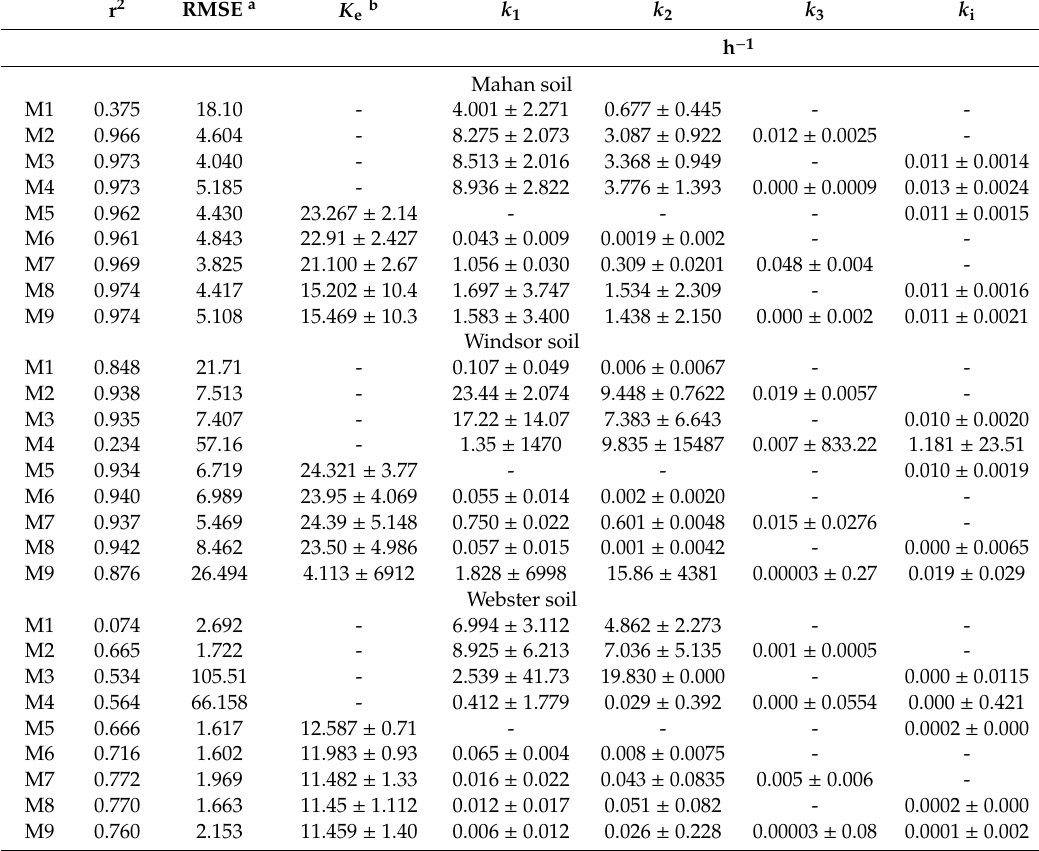
Table 2. Comparison of parameters and goodness-of-fit determined from fitting di ff erent MRM model formulations (M1–M9) to kinetic batch data for Webster, Windsor, and Mahan